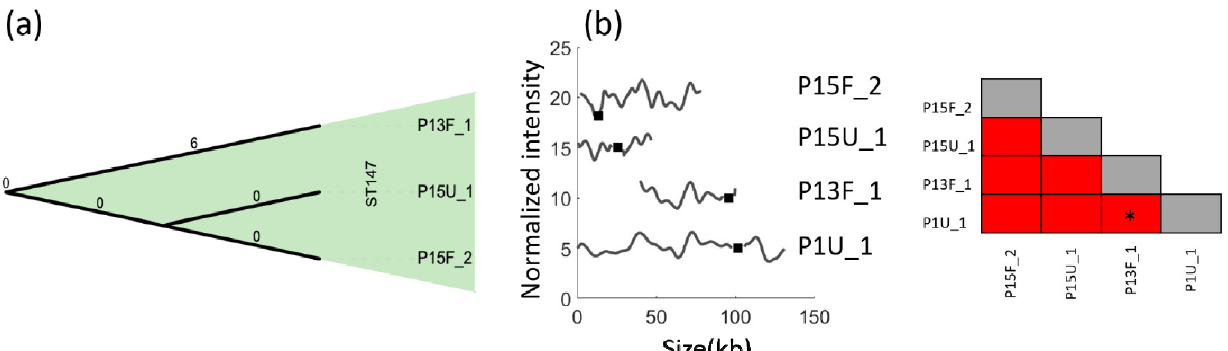
Figure 4. ( a ) Minimum spanning tree (grape tree) for all ST147 isolates based on cgMLST. The numbers on the solid black lines correspond to the number of alleles that differ between each isolate. ( b ) Barcodes of all ST147 isolates compared with the common ST16 plasmid (P1U_1) where the x-axis shows the length of plasmids in kb and the y-axis is the normalized intensity in arbitrary units, and the intensity plot of each isolate is shifted five units vertically for clarity. Black squares and gray shades represent the location of the bla NDM-1 gene. To the far right is the similarity matrix of bla NDM-1 -carrying plasmids in these three ST147 isolates. P13F_1 vs. P1U_1 yielded identical barcodes for overlapping regions, but with p > 0.01, and is denoted by a * in the similarity matrix .